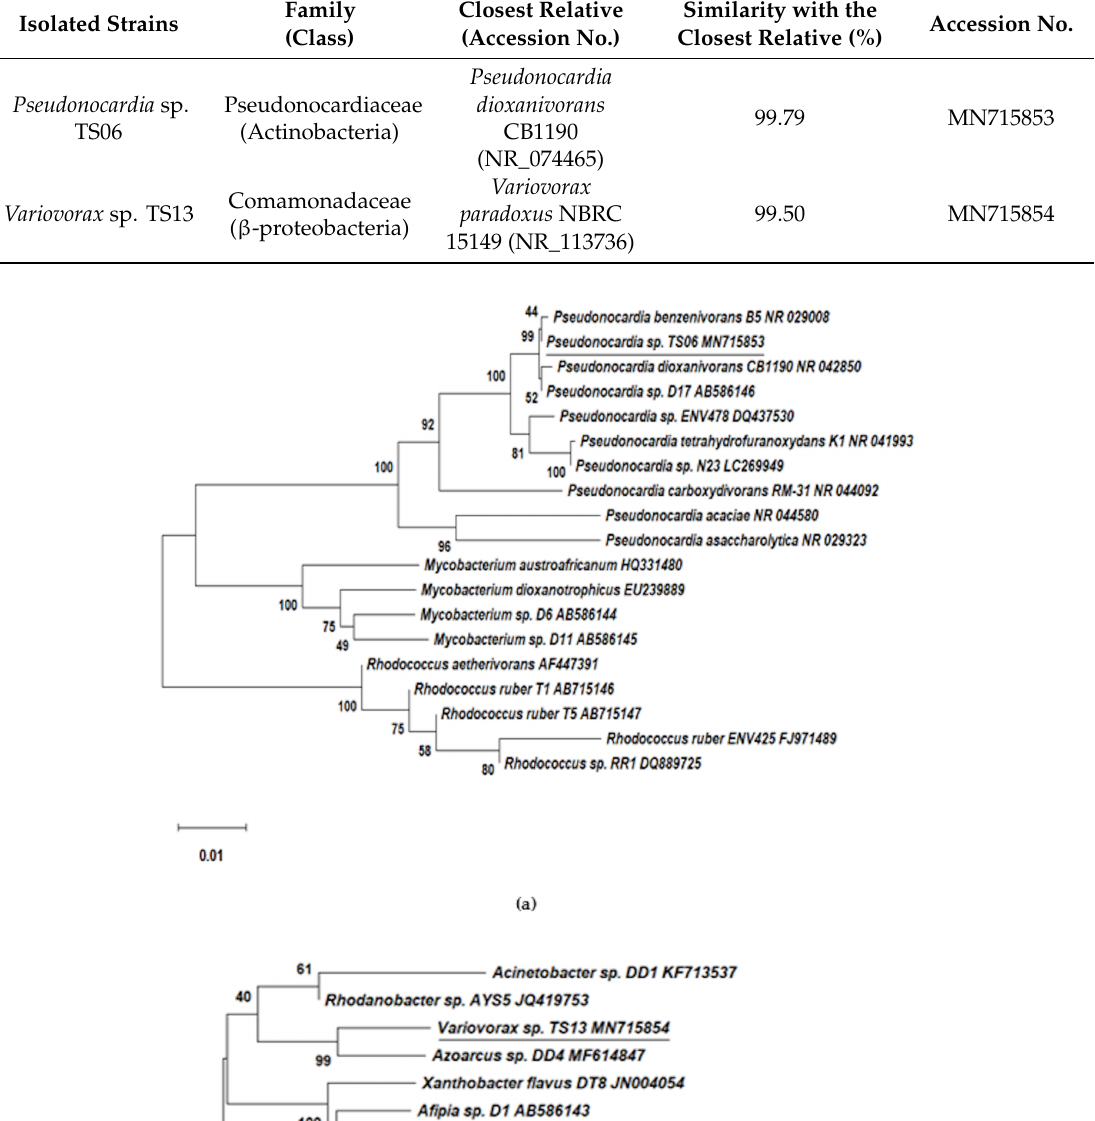
Table 2. Identification of 1,4-dioxane-degrading bacterial strains and their closest relatives. Isolated Strains